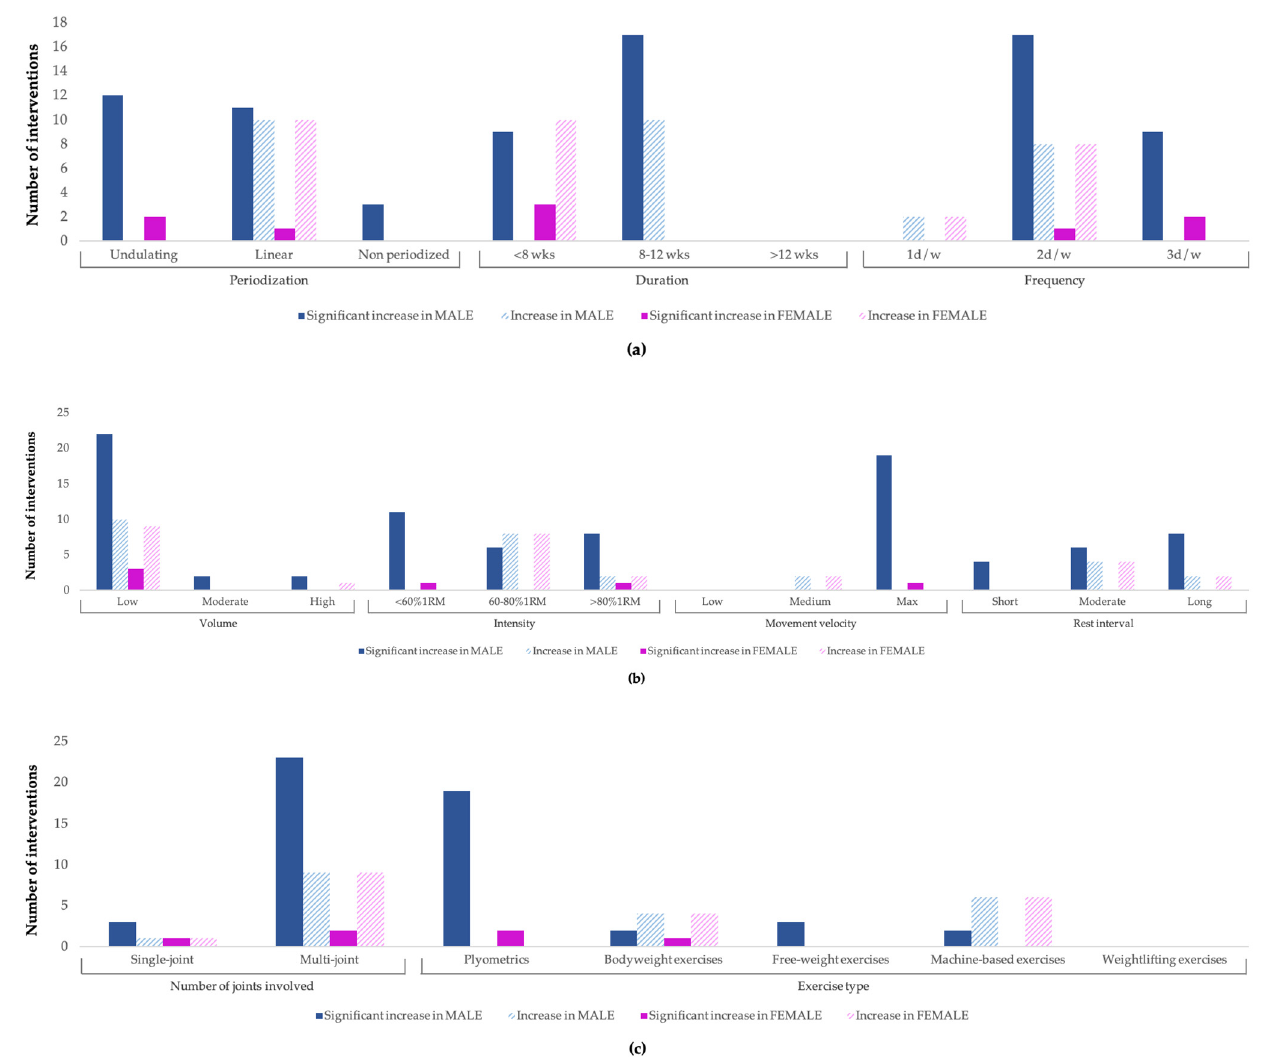
Figure 5. ( a – c ) Three ‐ block adaptation effects of STVs on jumping ability according to gender.